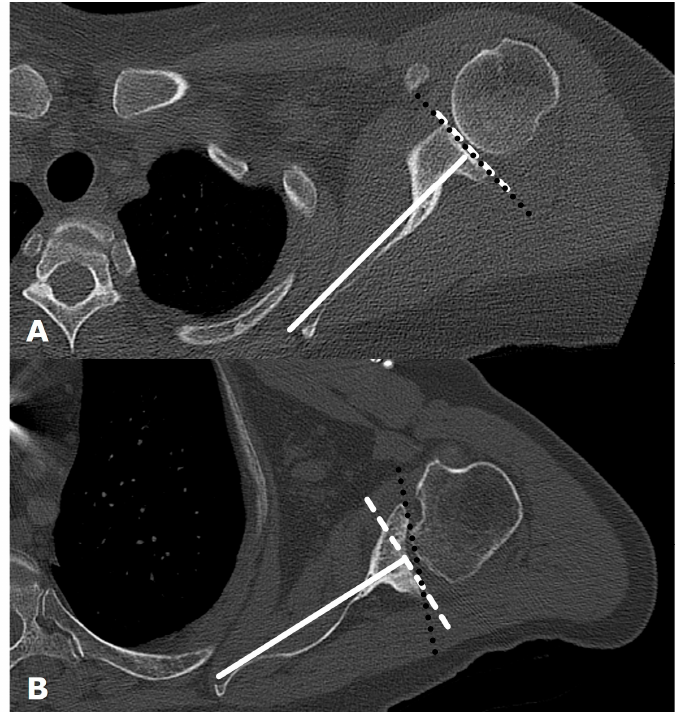
Figure 8. Axial CT images from two di ff erent patients ( A ). Normal glenoid version. ( B ). Retroversion secondary to glenoid erosion from osteoarthritis. A line (solid white) is drawn from the superior medial scapular border to the center of the glenoid and a line (white dashed) is drawn perpendicular to this on the axial image at or just inferior to the tip of the coracoid. Glenoid version is the angle formed between the perpendicular line (white dashed) and a line (black do tt ed) drawn along the glenoid articular surface.